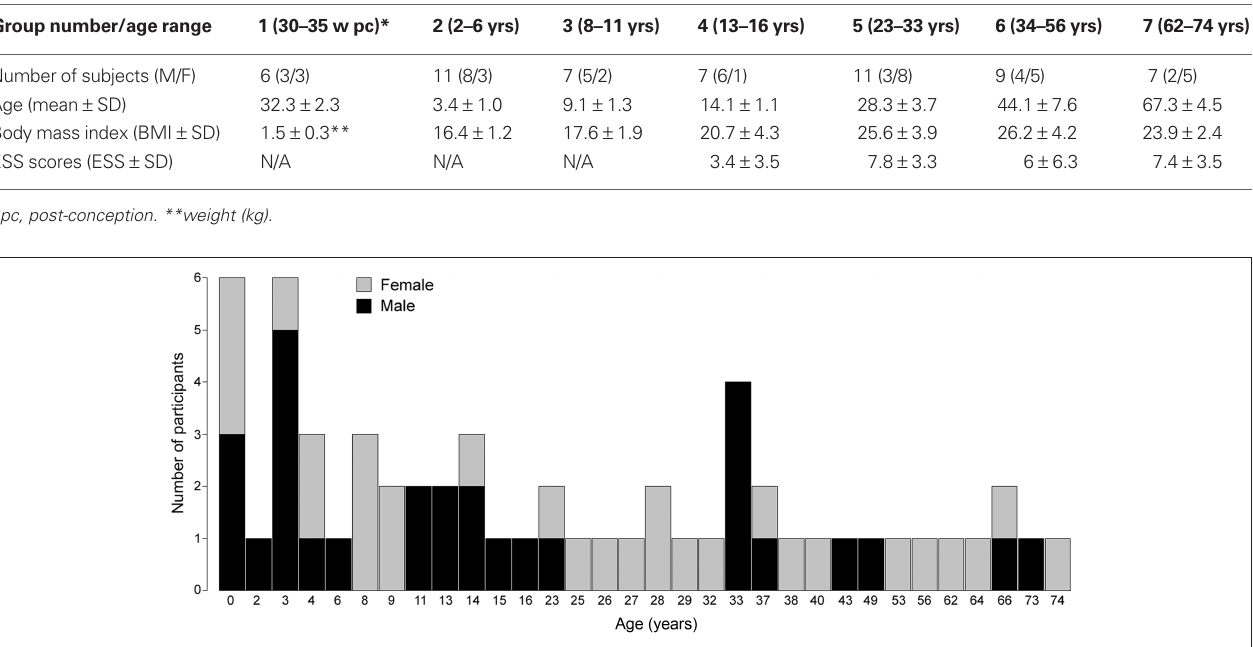
FiGure 1 | Graphical depiction of age and gender of all